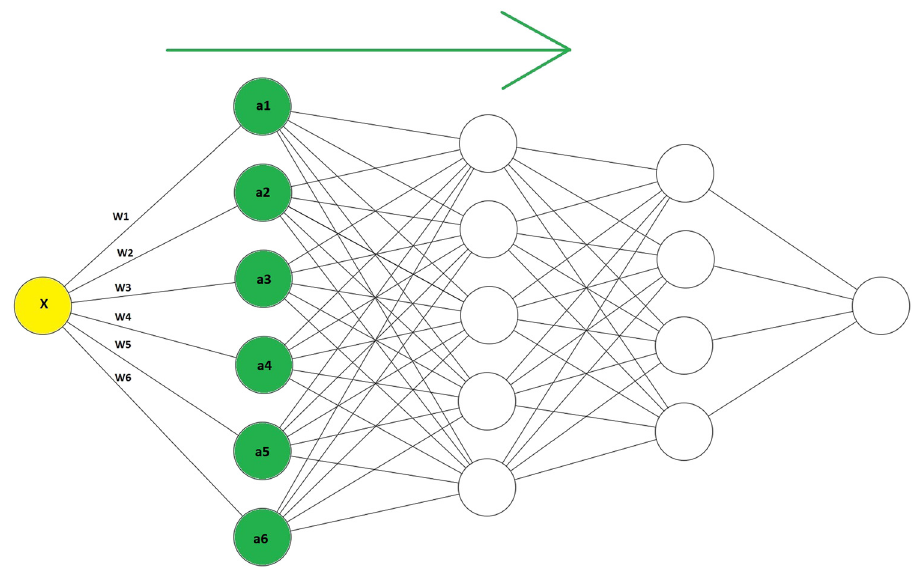
Figure 5: Process of transfer activation function in forwarding iteration.